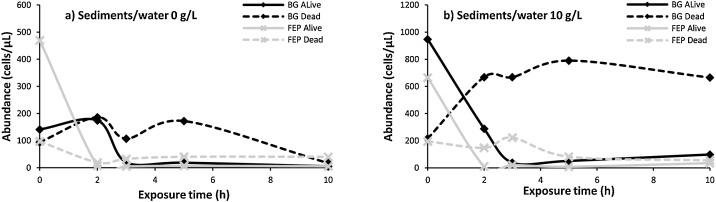
Variations of microorganisms activity (alive and dead cells) as a function of UV exposure time (0–10 h) in lacustrine samples (Peyrolles lake) in both sediments/water 0 g/L (a) and 10 g/L (b). Microcosms were performed using BG (black) and FEP (light grey) bottles.